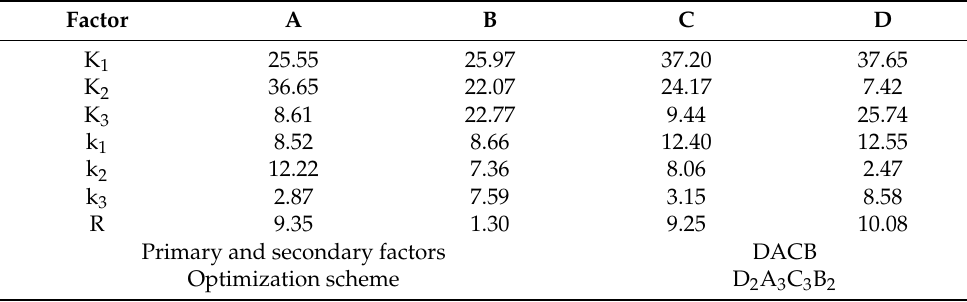
Table 6. The orthogonal experimental analysis regarding Ave.DFI .